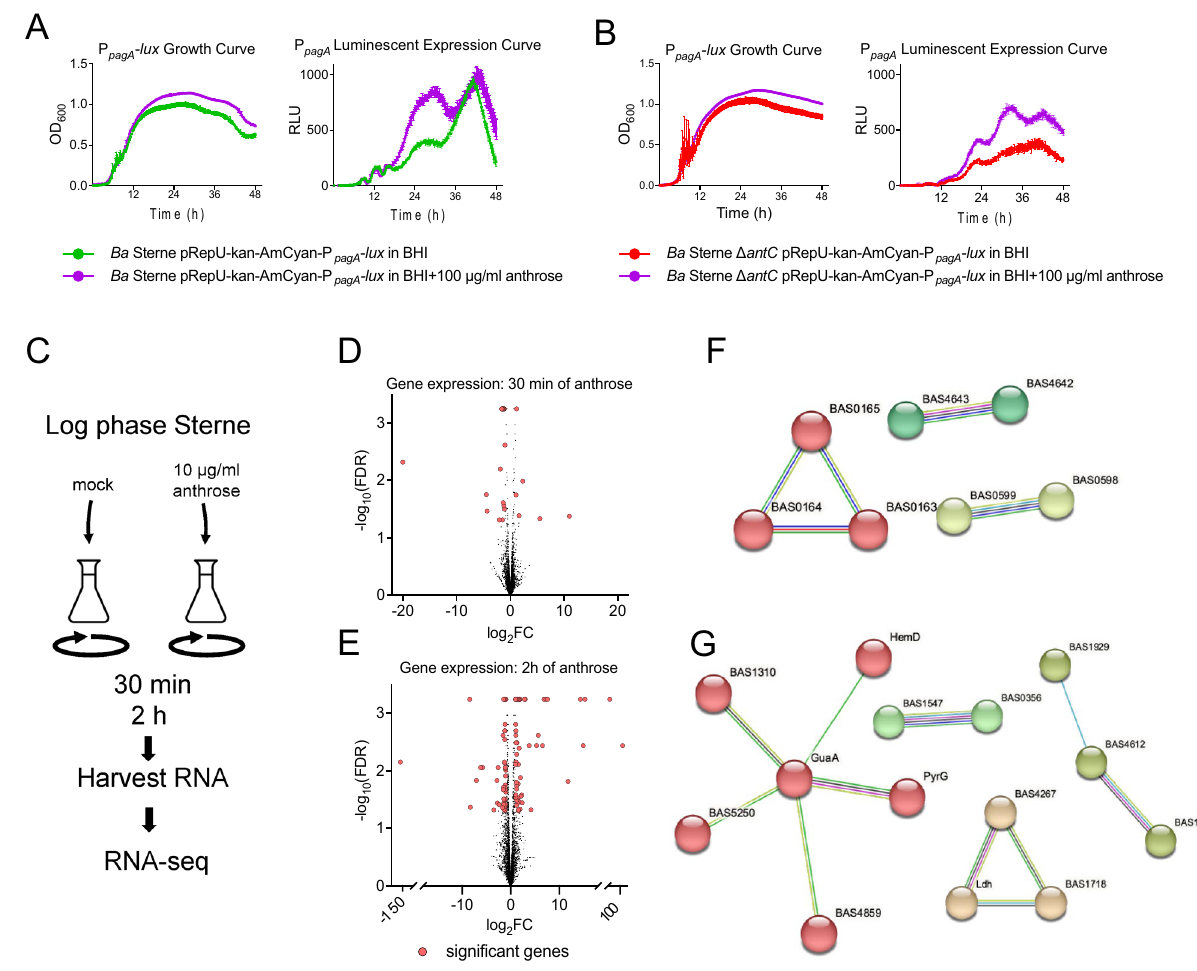
Figure 5. Anthrose induces changes in expression of protective antigen and affects global gene regulation in B. anthracis Sterne. ( A ) The B. anthracis Sterne protective antigen (PA) luminescent reporter strain was grown with (purple line) and without (green line) 100 μg/ml pure anthrose for 48 h. ( B ) The B. anthracis Sterne Δ antC protective antigen (PA) luminescent reporter strain was grown in BHI broth with (purple line) and without (red line)100 μg/ml pure anthrose for 48 h. Growth curves were carried out in triplicate with the OD at 600 nm and the average relative luminescent units (RLU) and standard error of the mean presented at each time point. ( C ) Experimental design to measure global transcriptomic levels at 30 min and 2 h after adding 10 μg/ml of pure anthrose to log-phase B. anthracis Sterne grown in BHI. Each sample was collected from three experiments and submitted to RNA-seq. ( D ) Gene expression of B. anthracis Sterne 30 min after addition of 10 μg/ml of pure anthrose compared to mock (water) treated culture grown in parallel and ( E ) after 2 h compared to mock (water) treated culture grown in parallel. Red dots indicate significant genes that experience a fold-change greater than 2 or less than -2 and have a false discovery rate less than 0.05. ( F ) String network functional analysis of 30 min gene clusters with BAS loci labels. The red cluster are related to glucokinase processes, the teal are ATP-transmembrane processes, and yellow are involved in sugar metabolism. Lines connecting genes are different evidence of interaction. ( G ) String network functional analysis of 2 h gene clusters with BAS locus labels. Nucleoside monophosphate (GMP and CTP) biosynthetic processes are part of the red cluster, the salmon group is glycolytic processes, yellow are other carbon metabolic processes, and green are involved in chemotaxis/two-component systems. Lines connecting genes are different evidence of